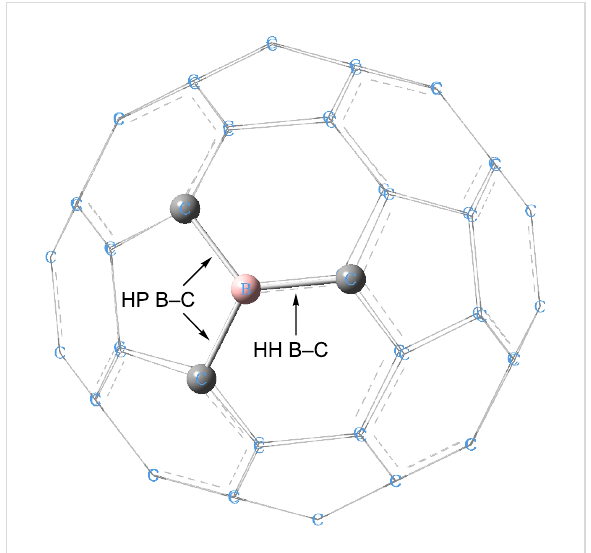
Figure 1: Sites for CO 2 adsorption on BC 59 . The B and C atoms of HH B–C and HP B–C sites are represented as ‘ball and bond’-type and the rest of the atoms are represented as ‘wireframes’. Atom colour code: grey, carbon; pink, boron.